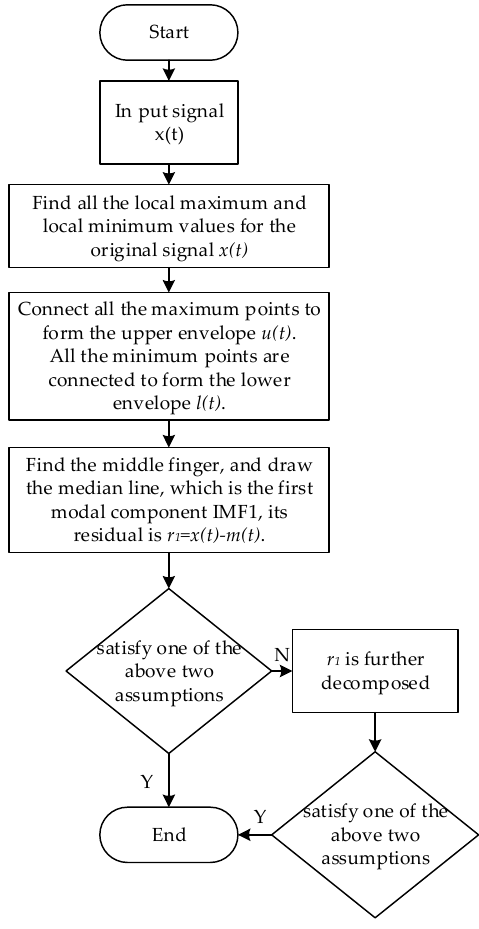
Figure 2. The empirical mode decomposition (EMD) algorithm.